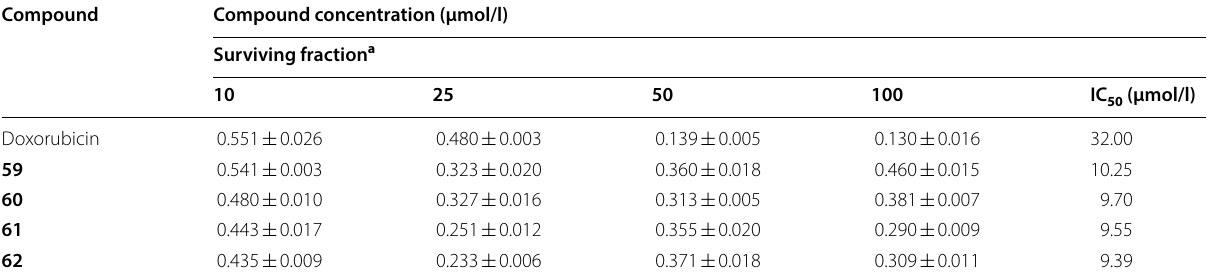
Table 13 In vitro anticancer screening of the newly synthesized compounds against the human breast cancer cell line MCF7